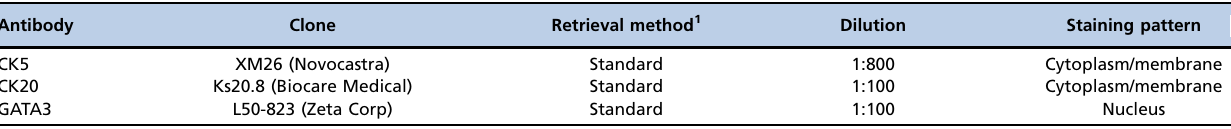
Table 1 - Summary of immunohistochemical procedures.